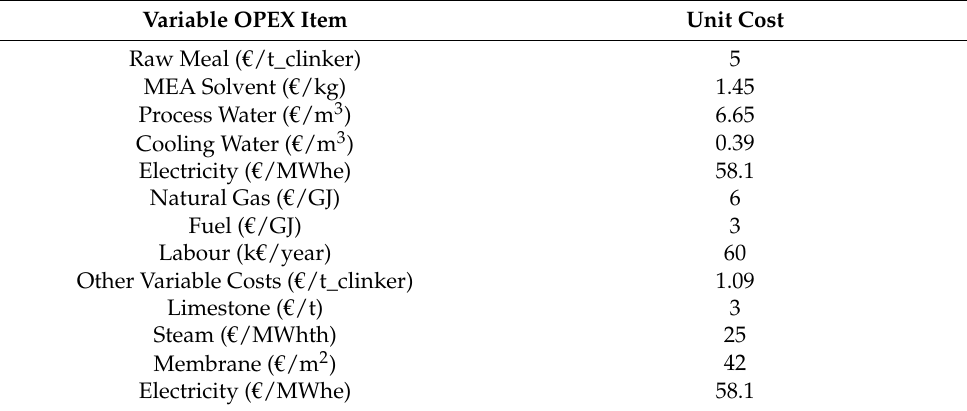
Table 3. Unit cost for variable operating costs calculation. Variable OPEX